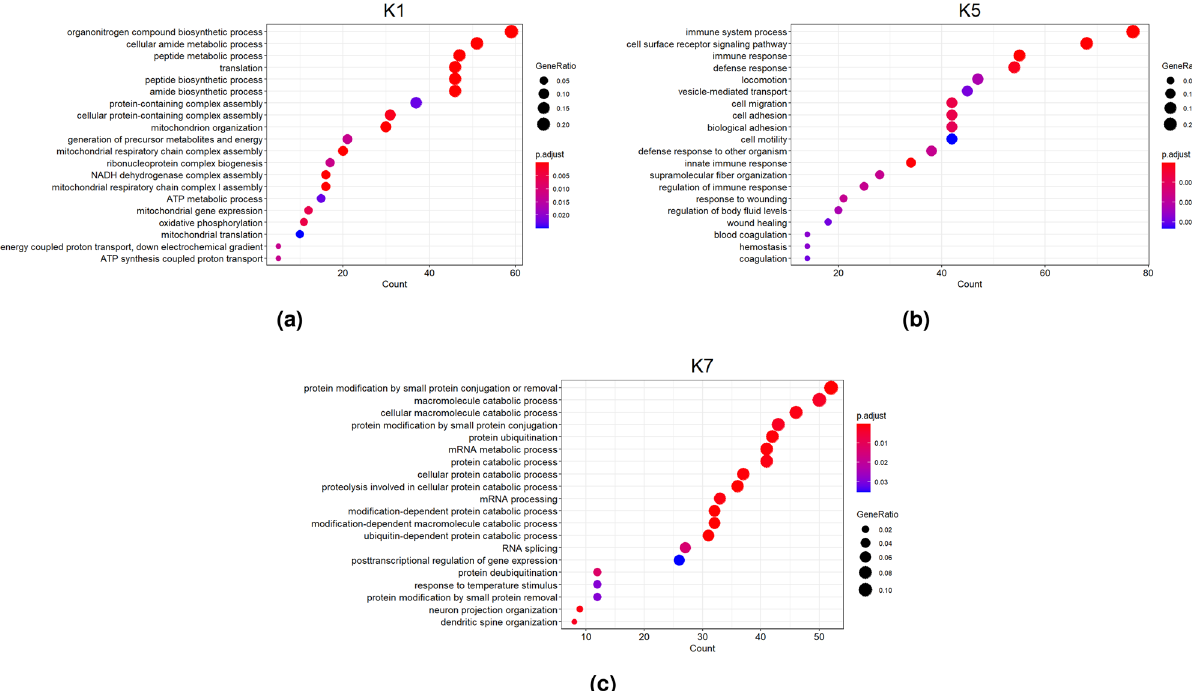
Figure 5. The biological processes of three significant modules: ( a ) K1, ( b ) K5, and ( c ) K7. p.adjust is a p -value adjusted by the Bonferroni